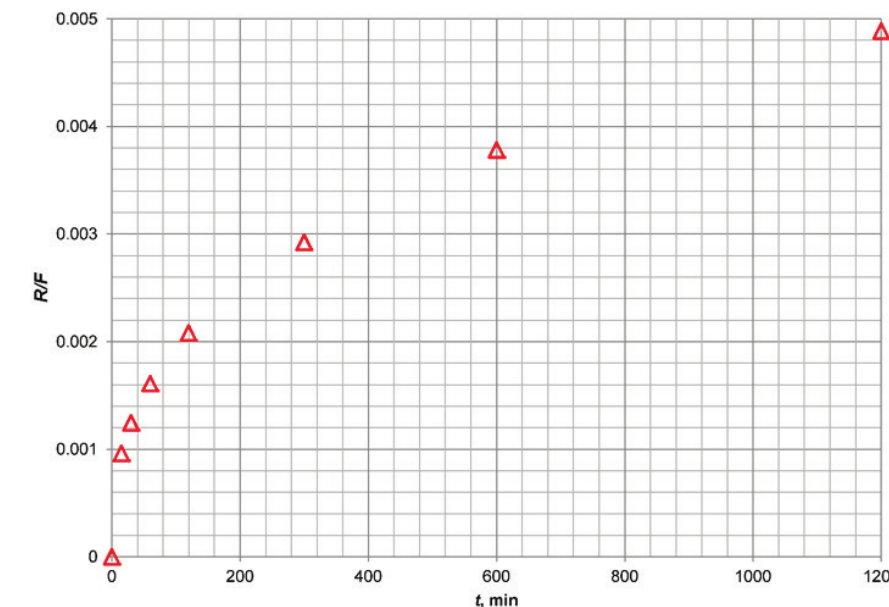
Fig. 7 – Relaxation contribution (R)/Fickian diffusion contribution (F) ratio with respect to time